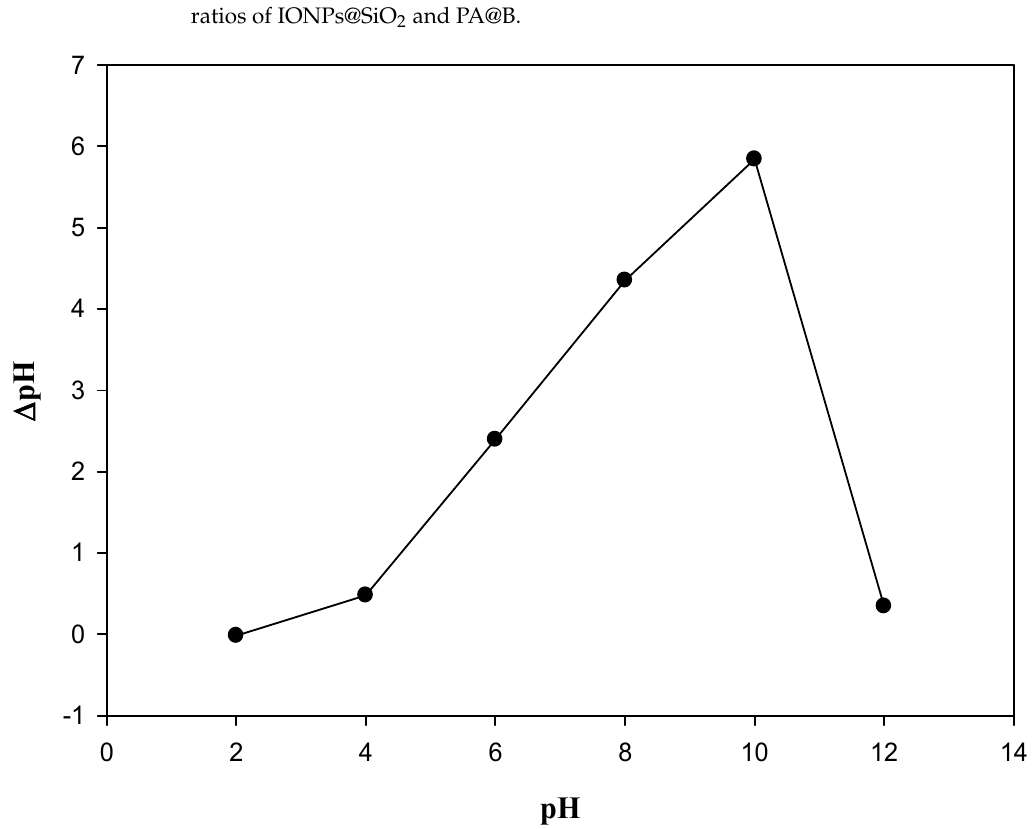
Figure 6. pHzpc of the fabricated composite materials (MCM-PA@B).